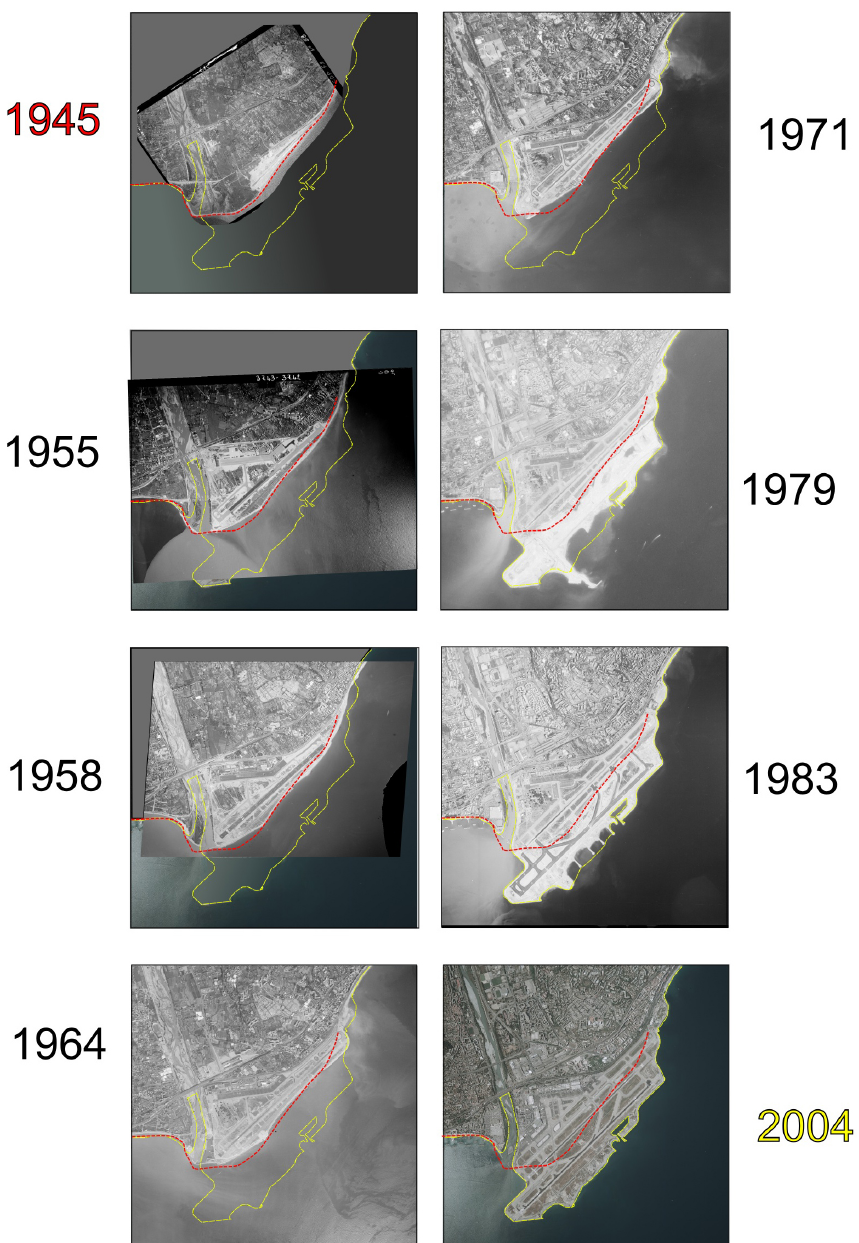
Figure 7. Sequence of aerial photos from 1945 to 2004 showing the evolution of the contour of the NCA airport (that has not changed since then). On all photos, the 1945 coastline contour is reported as a red dashed line and the actual contour as a yellow dashed line. The 1979 photo shows the extension of the newly built seawall before it collapsed into the sea, in October 1979 (photo credit: geoportail.ign.fr).